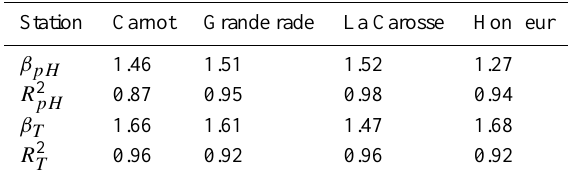
Table 3. Values of the spectral slope β for pH and temperature series, and R 2